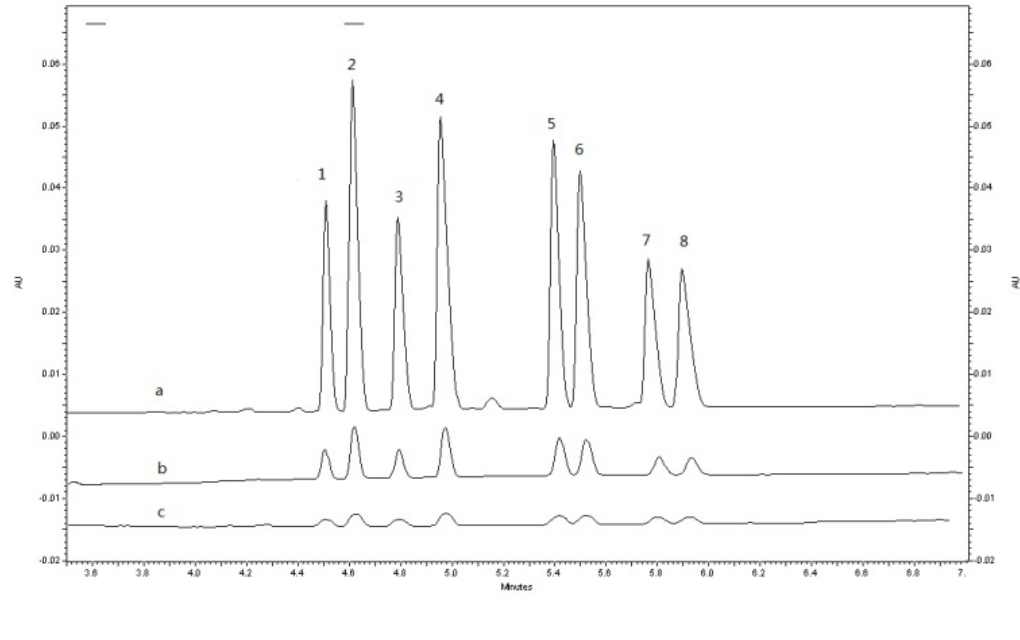
Figure 4. The effect of different sample solvents on FASS of rac -MRT (50 ng/mL)and its metabolites standard. Running buffer: 25 mM phosphate-6.25 Mm borate (pH 2.8) with 5.5 mg/mL CM- β -CD; Electropherograms: ( a ) 80% ACN–distilled water; ( b ) distilled water; ( c ) 10% buffer. Peaks: (1) ( − )- R -DMR; (2) ( − )- R -MRT; (3) (+)- S -DMR; (4) (+)- S -MRT; (5) ( − )- R -8-OHM; (6) (+)- S -8-OHM; (7) ( − )- R -N-O-MRT; (8) (+)- S -N-O-MRT.